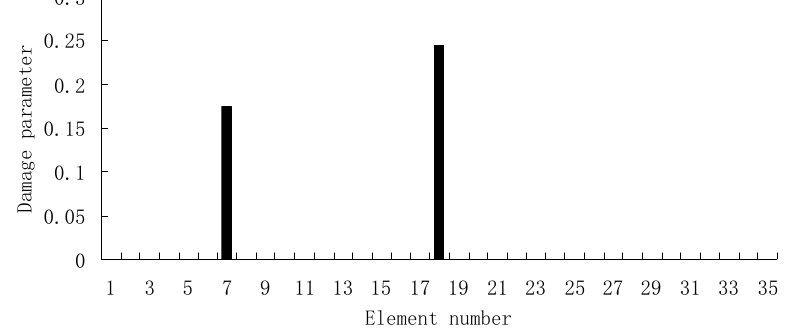
Figure 14. Damage evaluation result by the fifth computation of ESVT for case 2 (elements 7 and 18 had 15% and 20% stiffness reductions).